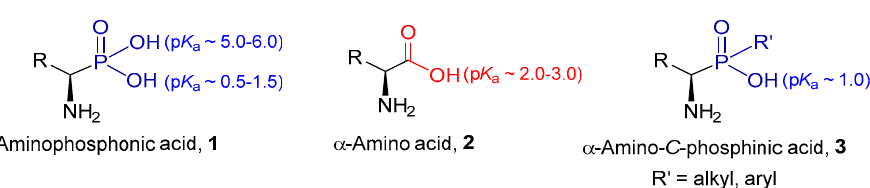
Figure 1. General structure for α -amino acids ( 2 ) and their phosphonic ( 1 ) and C -phosphinic ( 3 ) analogues.